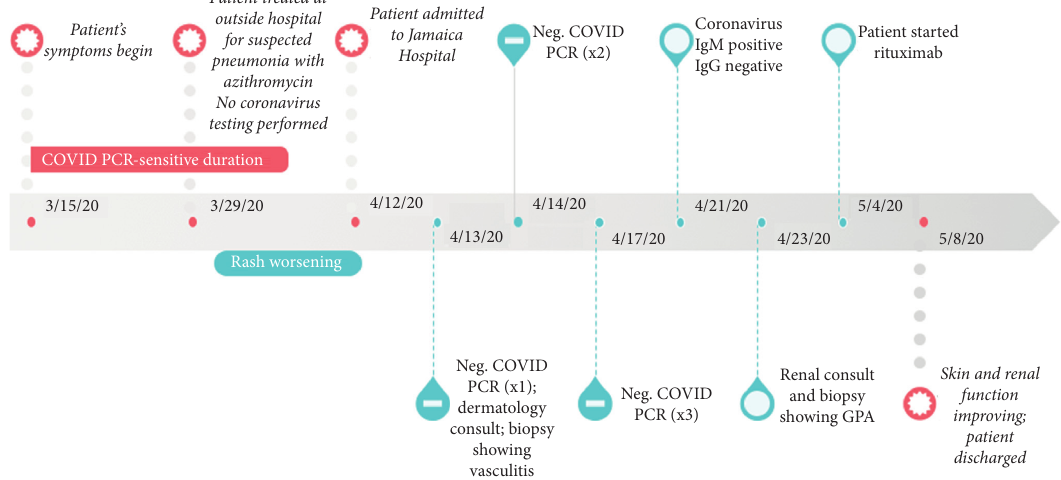
Figure 1: Timeline depicting onset of patient symptoms, test results, and disease